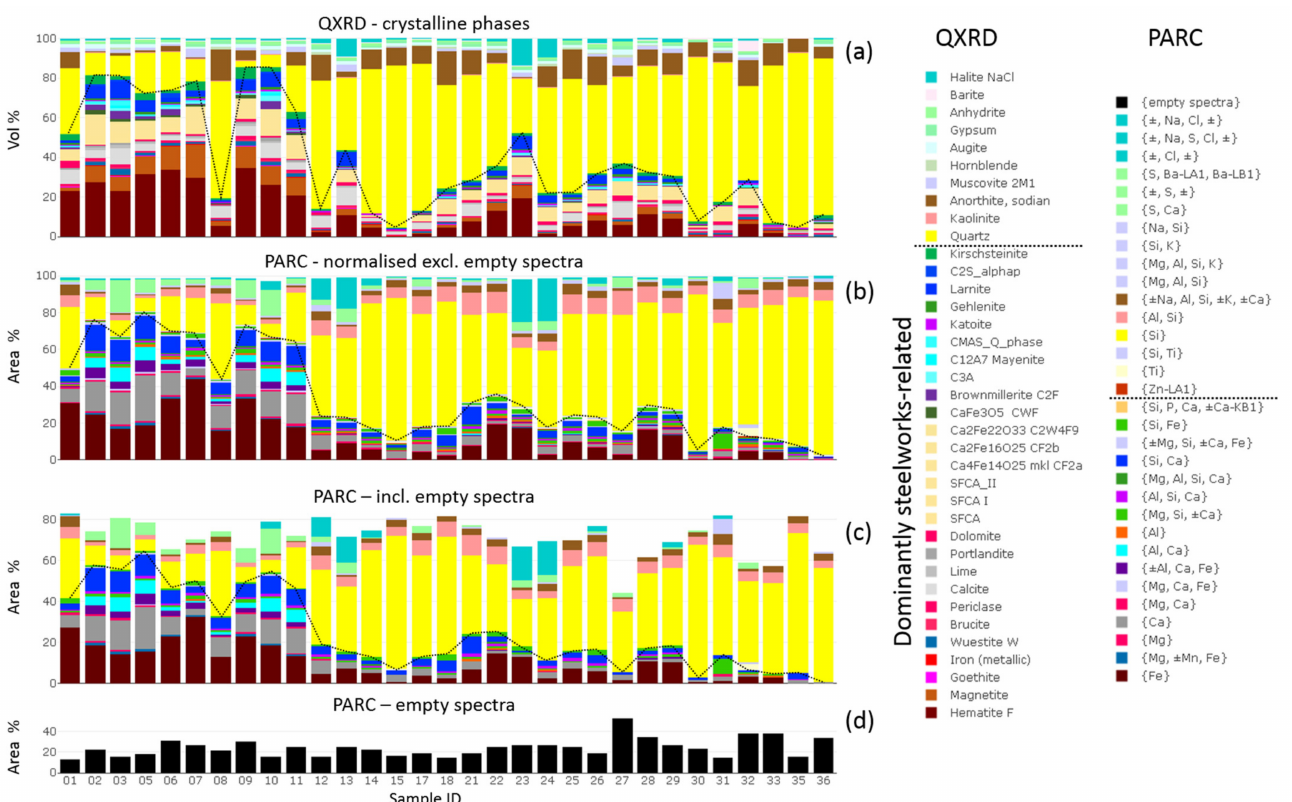
Figure 7. Overall sample mineralogy as analysed independently by QXRD ( a ) and PARC ( b – d ). QXRD crystalline phase proportions are reported as volume % and normalised to 100. PARC group abundances are reported as silhouette area % (of total analysed grains area), are filtered to show only those PARC groups exceeding a minimum threshold of 0.5 area % (per sample, including empty spectra). ( b ) shows the PARC group abundances normalised to total phases excluding empty spectra for comparison with QXRD results (see text for explanation). ( c ) shows group abundances including empty spectra, which are plotted separately in ( d ). The difference from 100 in ( c ) is dominantly made up of empty spectra, the rest comprising other groups with abundance <0.5 area % (the latter also accounts for the difference from 100 in ( b )). The line trace annotations bracket those XRD phases and PARC groups strongly associated with steelworks materials. PARC results are aggregates of triplicate areas analysed per